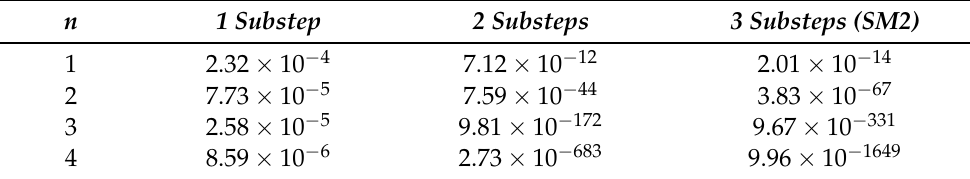
Table 5. || v n − v ∗ || for algorithm SM2.